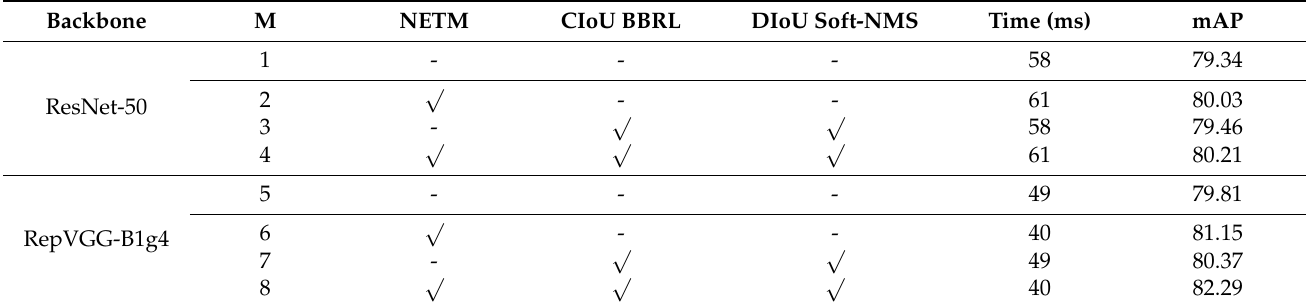
Table 3. Ablation study on AEMER dataset. Here we investigated three models, the original RetinaNet (M1), ResNet- RetinaNet (M2-4), and RepVGG-B1g4-RetinaNet (M5-8). The NETM represented the neighbor erasing and transferring mechanism. The BBRL was the bounding box regression loss. The detection speed was measured by Time with a single 1660Ti GPU using a batch size of